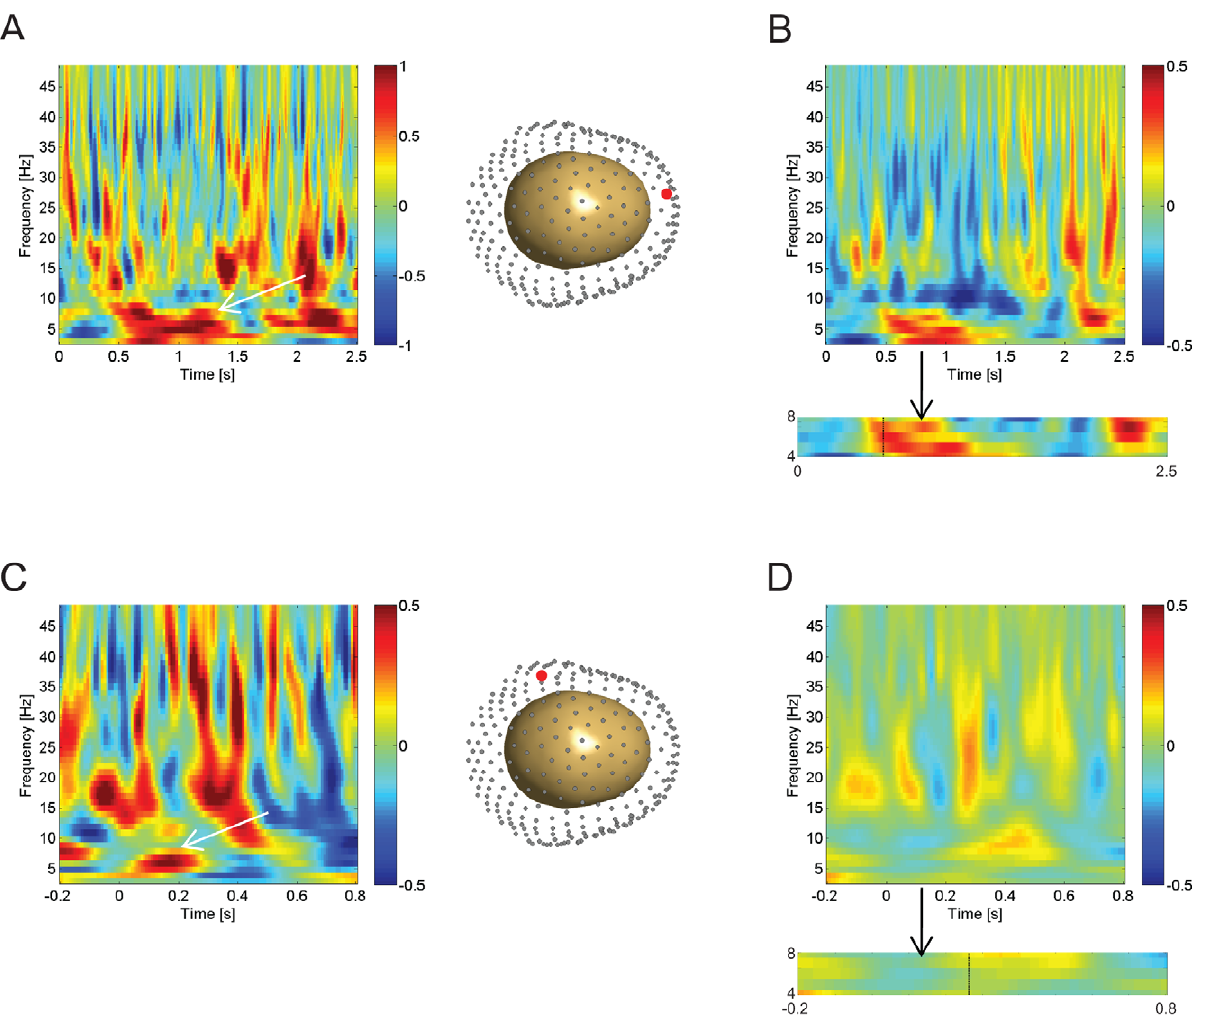
Figure 3. Performance-related MEG time-frequency effects. Subsequent performance effects are shown as the difference between time- frequency spectra for accurate trials versus inaccurate trials. Trials were divided into accurate and inaccurate according to whether replacement accuracy for that trial was above or below the participant’s median accuracy across all trials. (A) The effect of subsequent performance during the cue period, shown at an exemplary single sensor of interest, MLF51, whose middle left frontal location of the singe sensor is highlighted in red (right). (B) The effect of subsequent performance during the cue period averaged across all 270 MEG sensors. Box below highlights significant temporal cluster ( , 583 ms) within the theta band ( p , .001; format as in Figure 2). (C) The interaction of movement initiation and subsequent performance effects (i.e., the difference between the movement-initiation effects in accurate versus inaccurate trials), shown at an exemplary single sensor of interest, MLT15, whose posterior left middle temporal location is highlighted in red (right). (D) The interaction of movement initiation and subsequent performance effects averaged across all 270 MEG sensors. Box below highlights a significant temporal cluster ( , 283 ms) within the theta band ( p , .001; format as in Figure